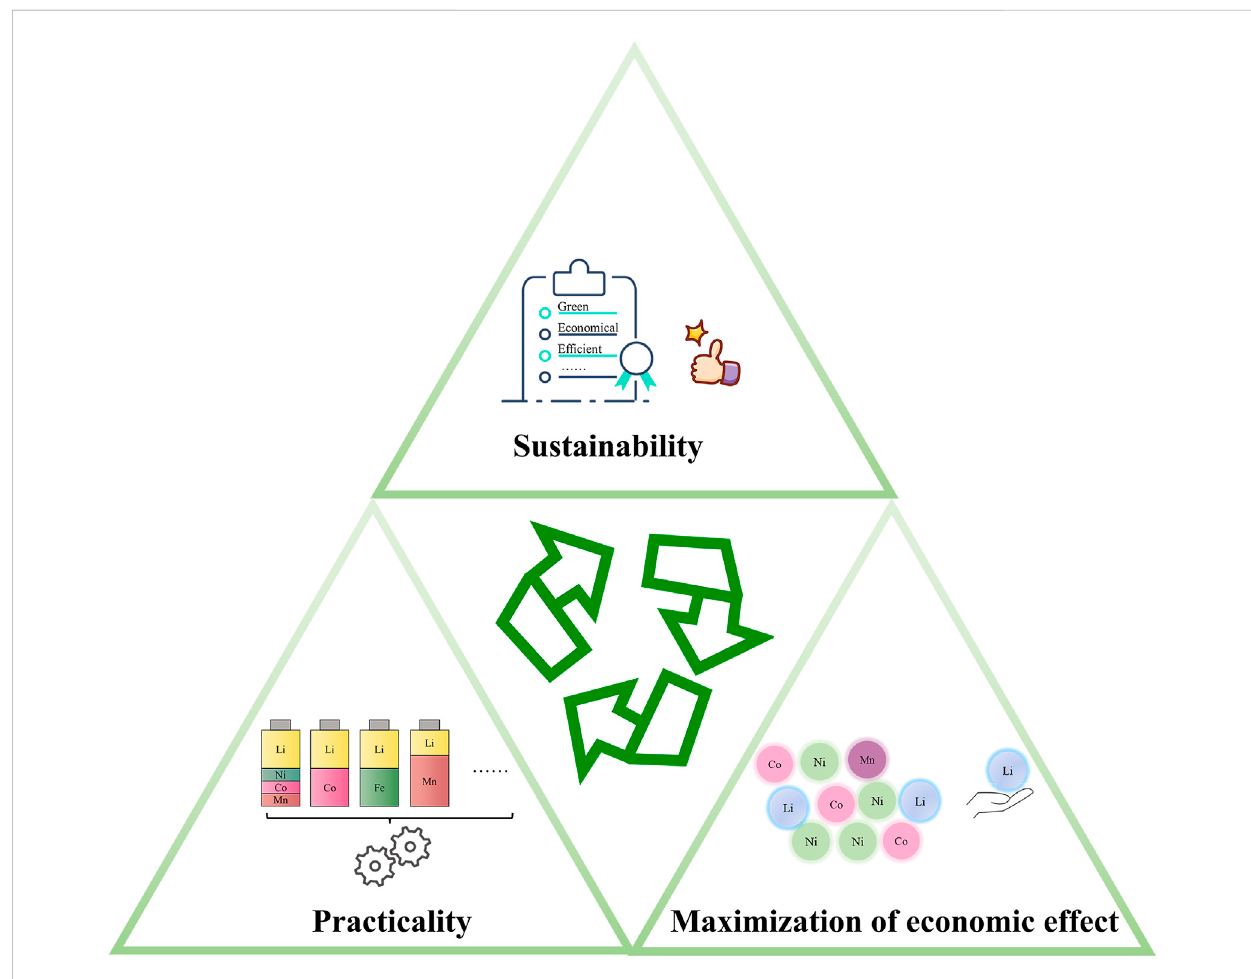
FIGURE 8 The future directions diagram for the future development direction of spent battery